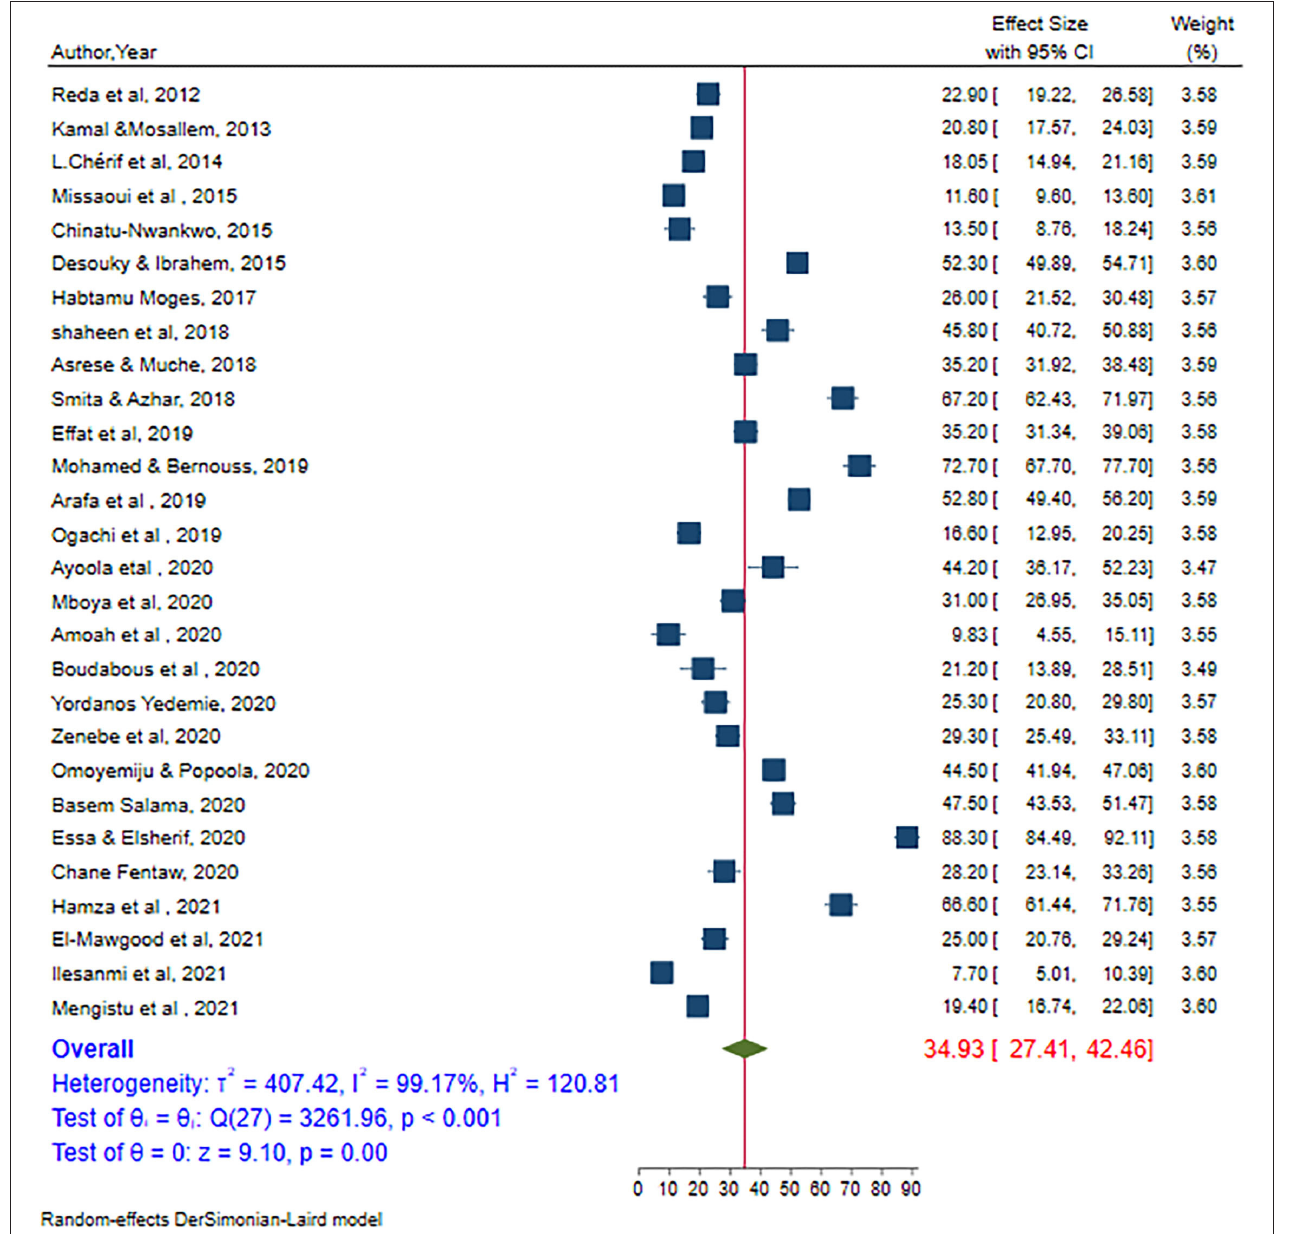
FIGURE 2 | The pooled prevalence of internet addiction among high school and university students in Africa.